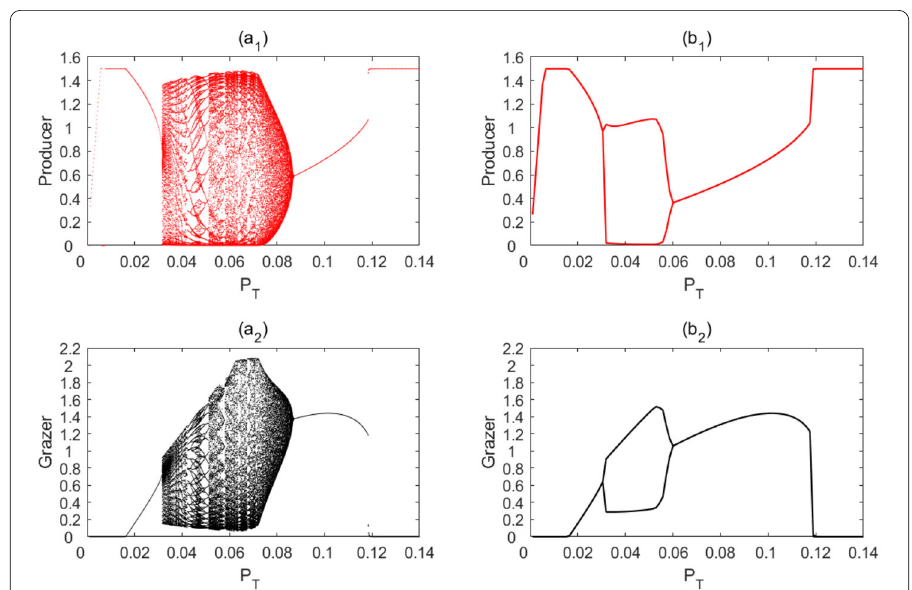
Figure 3 Bifurcation diagram of the population densities plotted against P T the discrete-time model (5.1) ( a i , i = 1,2) and continuous-time model (5.2) ( b i , i = 1,2). The values of other parameters are given in Table